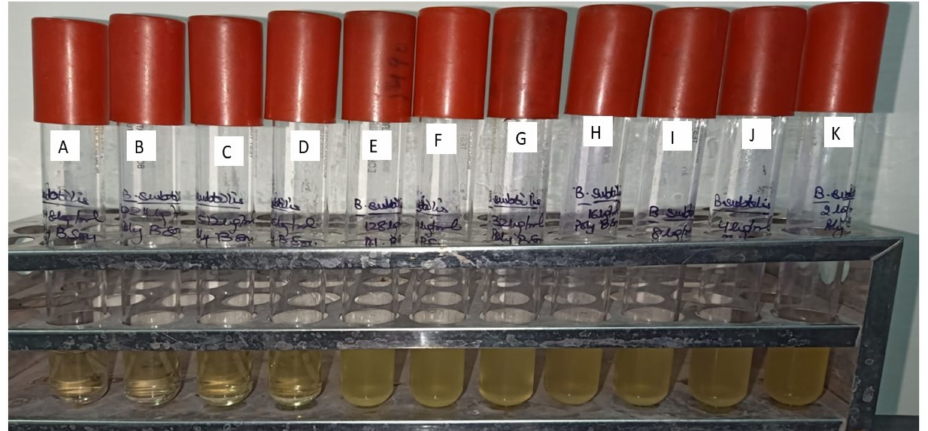
Figure 13. Minimum inhibitory concentration of Polymyxin B sulphate against Bacillus subtilis (MTCC 441) Muller Hinton agar broth tubes A to K dilution range from 1024 to 1 µ gmL − 1 . A—1024 µ gmL − 1